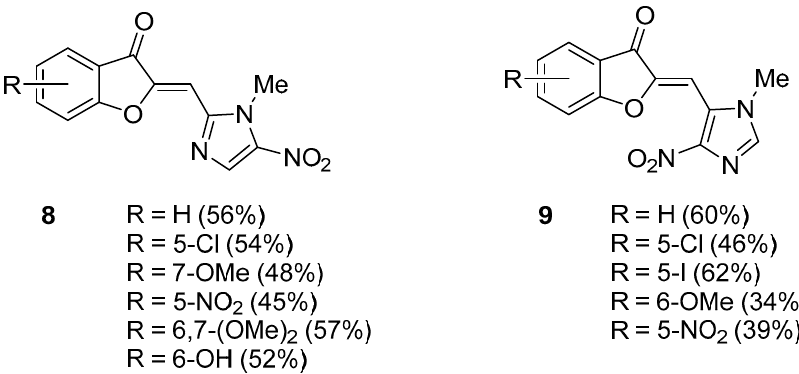
Figure 3. Structures and yields of some representative compounds 8 a nd 9 synthesised according to Scheme 2. Scheme